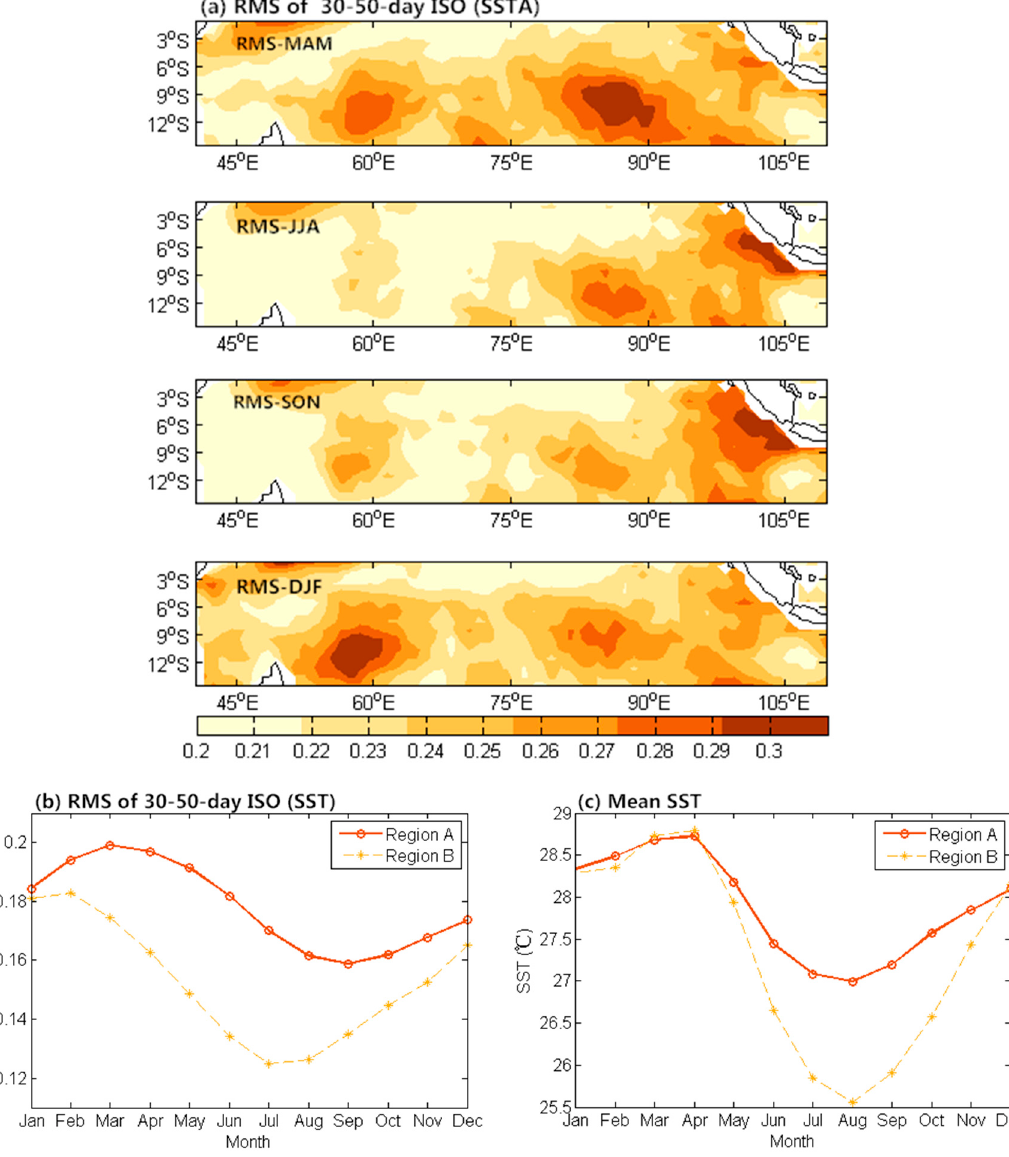
Figure 3. ( a ) RMS variance distribution of 30–50-day SST (°C) variability in different seasons; and spatial-averaged: ( b ) RMS variance; and ( c ) mean SST in Regions A and B as a function of calendar month during 1982 – 2016.